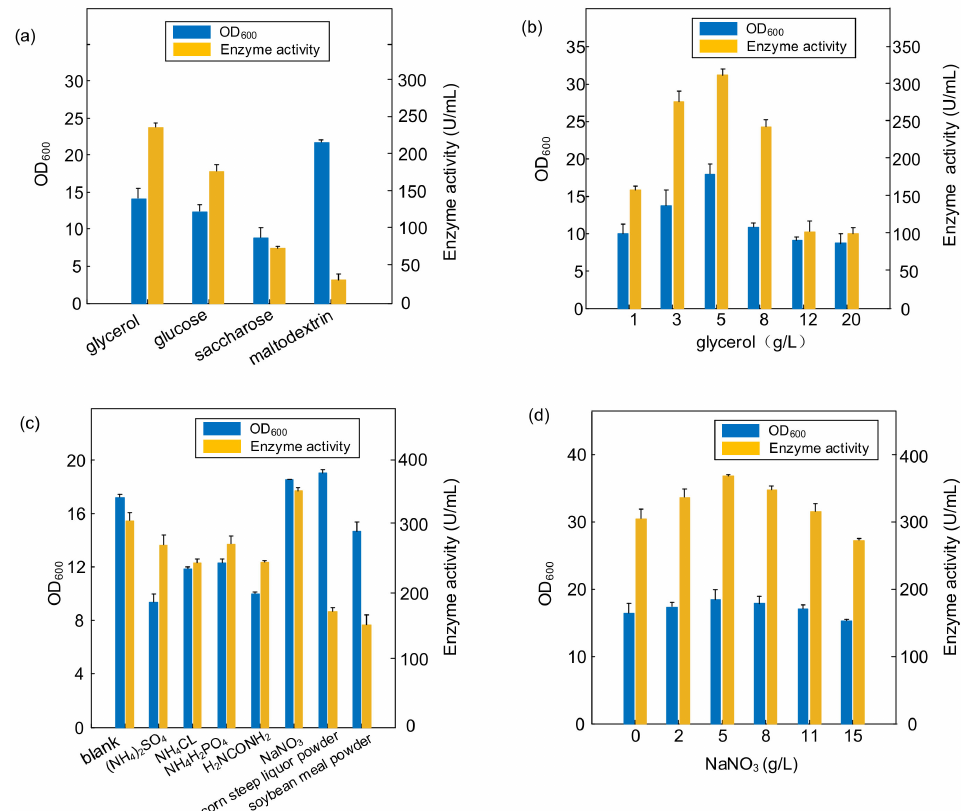
Figure 6. ( a ) Effect of different carbon substrates; ( b ) effect of the ratio of glycerol addition; ( c ) effect of different nitrogen substrates; ( d ) effect of the ratio of NaNO 3